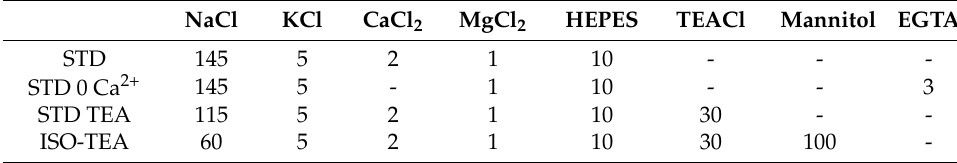
Table 1. Composition of the extracellular solutions (in mM; pH was